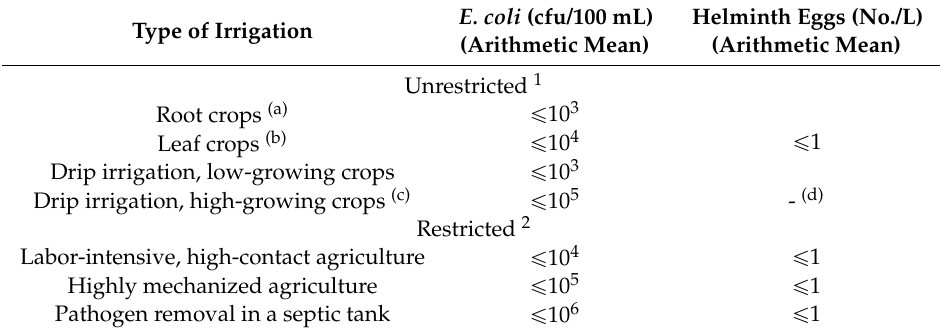
Table 3. Recommended minimum verification monitoring of microbial performance targets for wastewater use in agriculture (modified from WHO